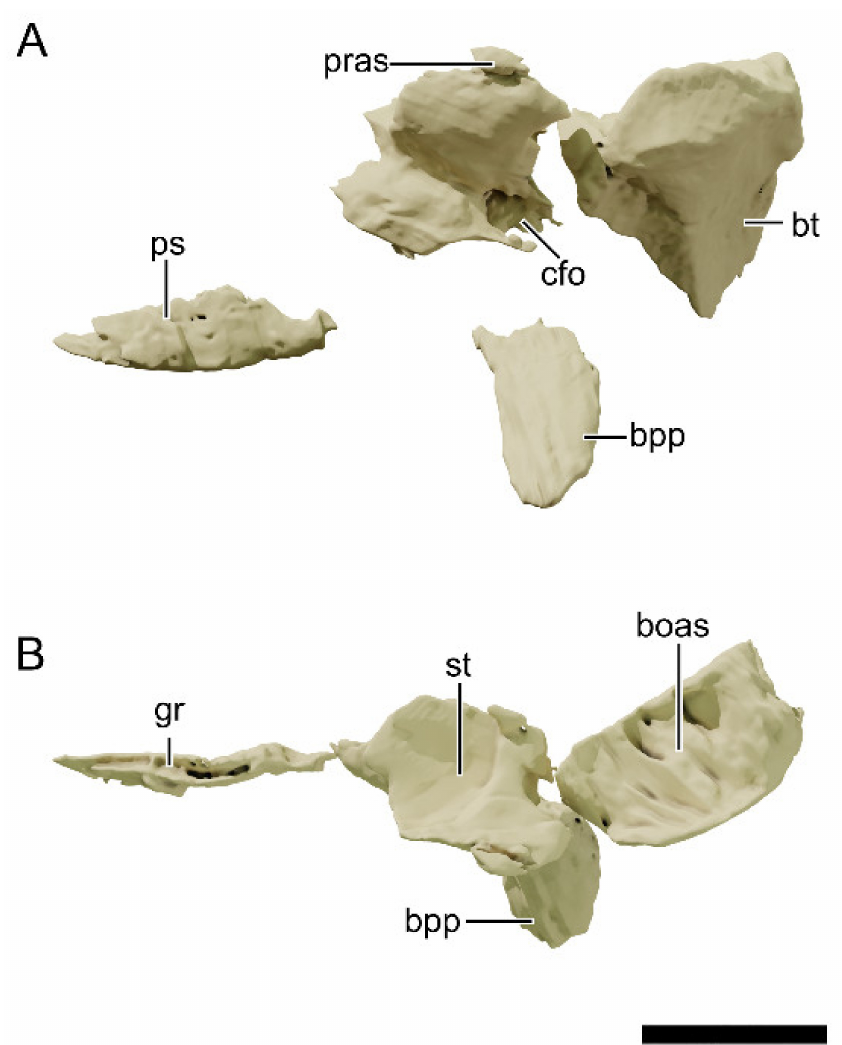
Figure 23. Digital reconstruction of the basisphenoid of NHMD 164741. ( A ) Lateral view. ( B ) Dorsal view. The elements were articulated digitally for the reconstruction. Abbreviations: boas, articular surface for the basioccipital; bpp, basipterygoid process; bt, basal tubera; cfo, carotid foramen; gr, groove; pras, articular surface for the prootic; ps, parasphenoid; st, sella turcica. Scale bar = 20